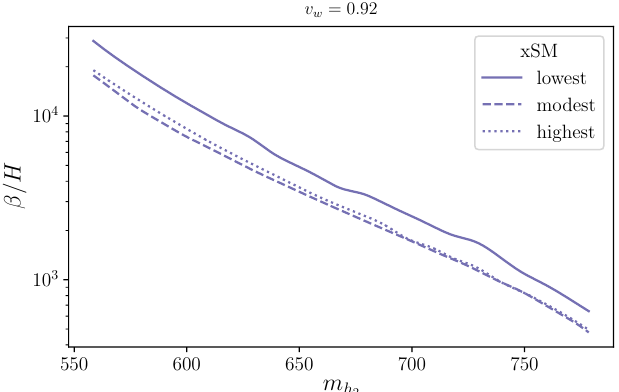
Figure 11 . xSM : the inverse time duration of the phase transition at the different levels of diligence using eq. [(2.6), (2.13), (2.37)]. The lowest and modest diligences are estimated using the first derivative of the action dS/dT and the highest diligence is computed directly from the mean bubble separation. The temperatures are set to T and highest diligence